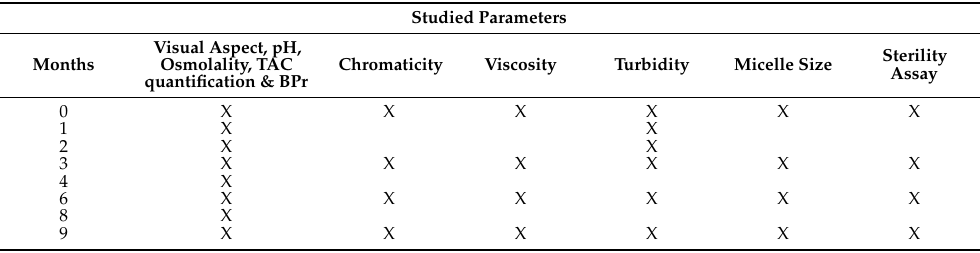
Table 2. Summary of analyses at each analysis time (X: assessed parameters). TAC: tacrolimus; BPr: breakdown product